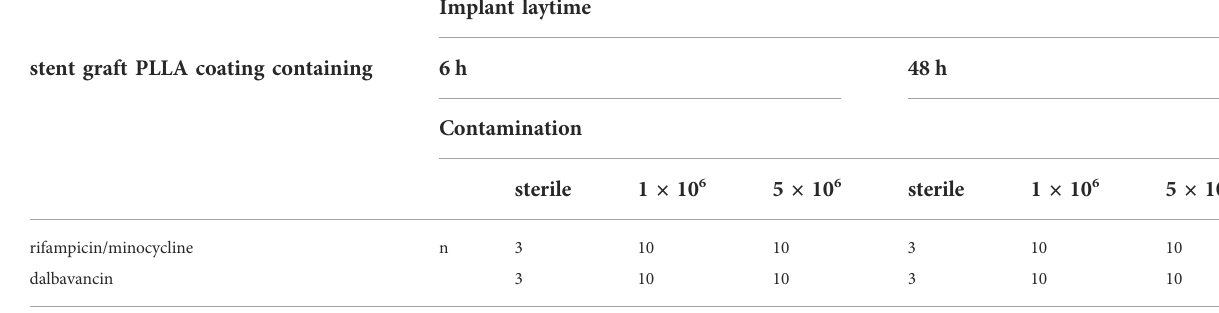
TABLE 1 Experimental groups for tail vein mouse model.